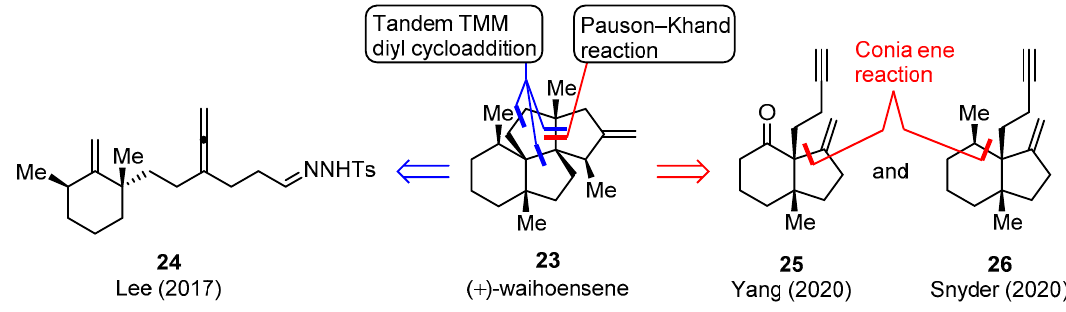
Figure 5. Comparison of the retrosynthetic strategies.